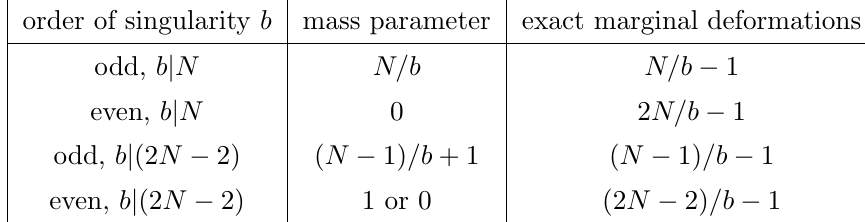
Table 3 . Summary of mass parameters and number of exact marginal deformations in D N . Note when b is even divisor of 2 N (cid:0) 2 but not a divisor of N (cid:0) 1, the number of mass parameter is zero, otherwise it is one.